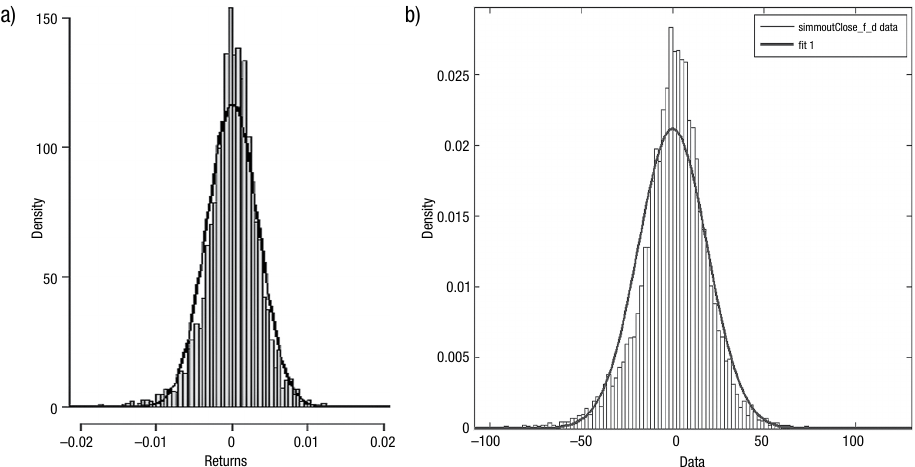
Fig. 23. Real distributions (1990–2004) (a) and statistically very close simulated distributionwith mean 0.0058, std. 18.7915, kurtosis 5.3880, skewness 0.4141